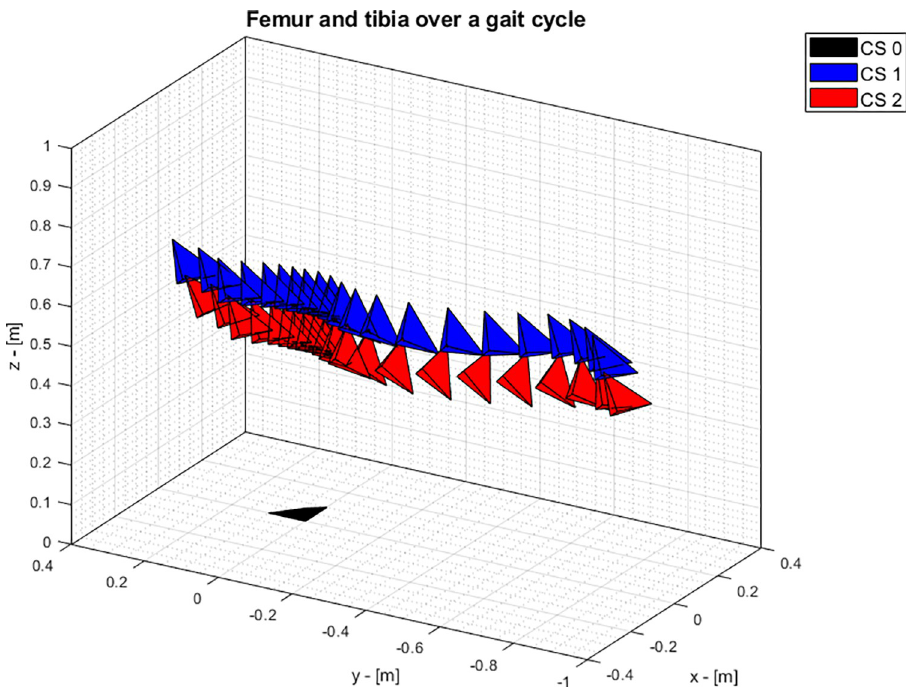
Fig 4. Poses of femur and tibia across one gait cycle. The motion progresses from the left to the right. CS0 is the world coordinate system, CS1 is the coordinate system attached to the femur, CS2 is the coordinate system attached to the tibia. For CS 1 and CS 2, the x-axis is pointing forward, the y-axis is pointing upwards while the z-axis is on the medio-lateral direction. Hinge joint. An artificial, custom-made hinge was left free to swing after an initial pertur- bation. The swing motion was recorded by means of an optoelectronic system (Vicon MX 1 , Oxford, UK, 10 cameras, sampling frequency 100 Hz) and passive markers attached to the hinge segments. The coordinate systems attached to each segment were reconstructed by swing cycle was discarded to remove possible artifacts and the analysis was limited to the sec- ond complete swing cycle.